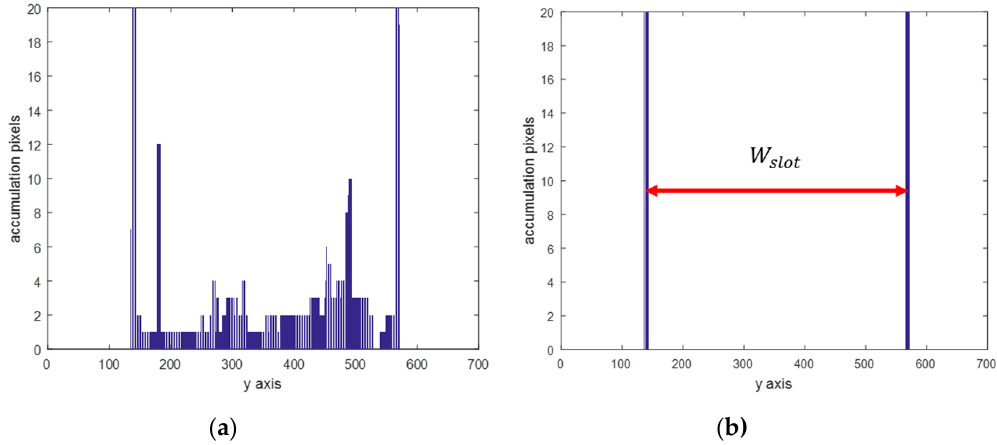
Figure 11. Parallel parking. ( a ) Scanned distribution; ( b ) Distribution after filtering.